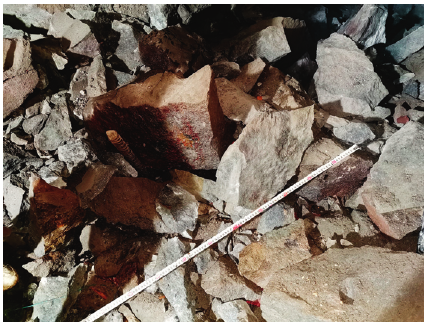
Figure 15: Rock Table 2: Results of vibration velocity monitoring.